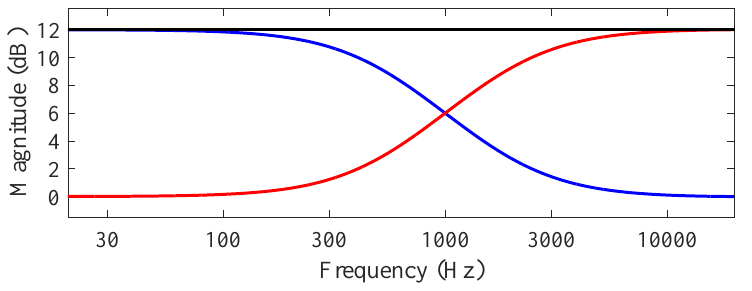
Figure 2. Magnitude responses of a low (blue) and high (red) shelf filter with a 12-dB gain and 1-kHz crossover frequency, and the cascade of the two filters